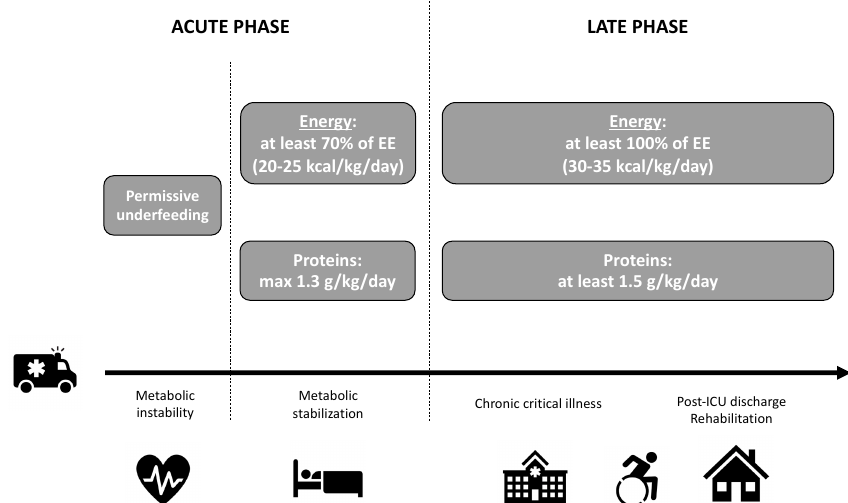
Figure 2. Calories and proteins provision by oral route, according to the successive phases of the critical care pathway (adapted from [23,39,41]). Abbreviations: EE, energy expenditure; max, maximum.